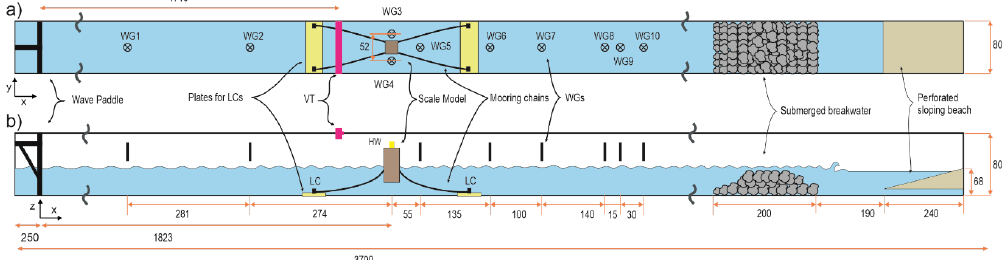
Figure 1. Experimental set in the LABIMA-WCF (Wave–Current flume of the Maritime Engineering Laboratory (LABIMA) at Florence University) wave flume. A submerged breakwater and a perforated sloping beach are used for absorption of reflected waves at the end of the wave flume: ( a ) plan view, ( b ) middle line cross-section (all dimensions are in cm).